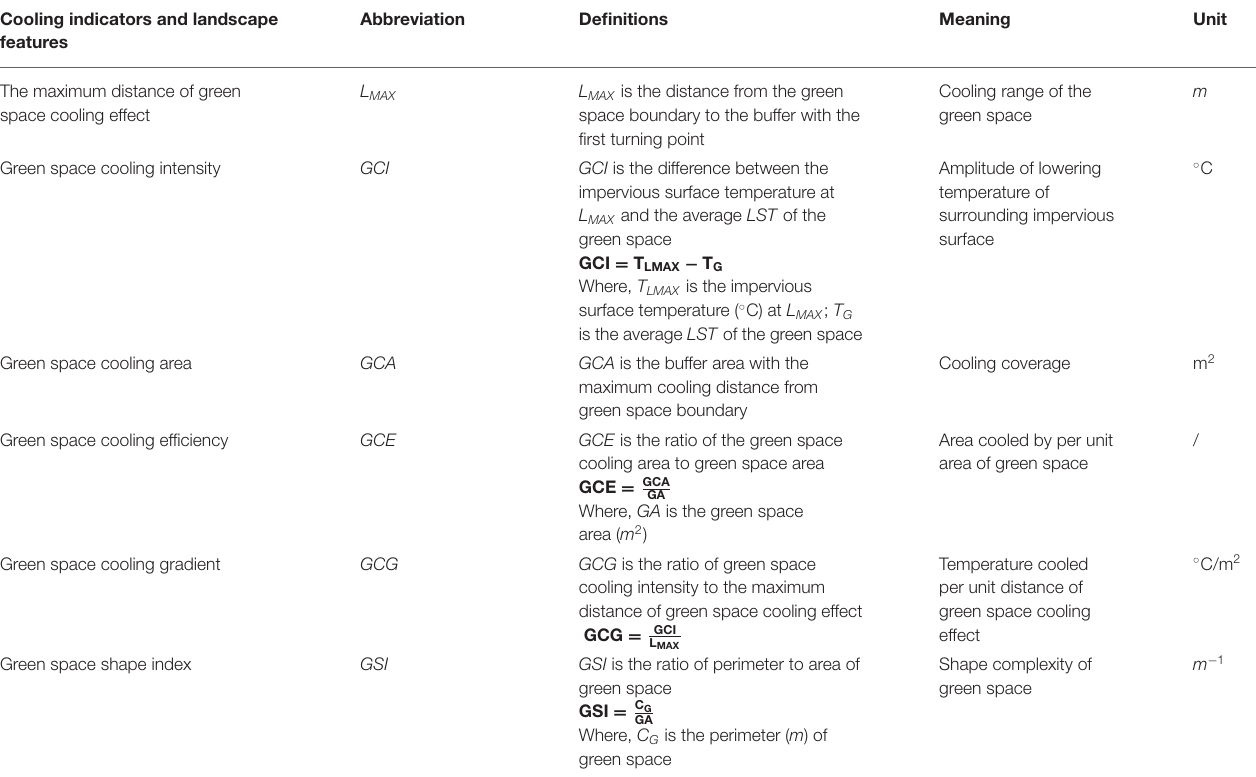
TABLE 1 | Definition of cooling and landscape indices.